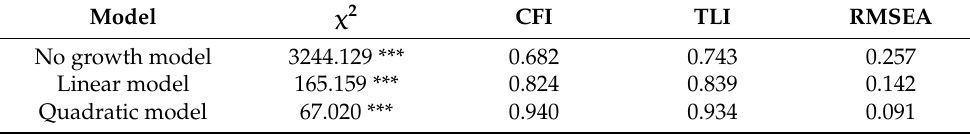
Table 2. Model fit of Latent Growth Modeling for Older Adults’ Smoking Behavior Changes. Model χ 2 CFI TLI RMSEA No growth model 3244.129 *** 0.682 0.743 0.257 Linear model 165.159 *** 0.824 0.839 0.142 Quadratic model 67.020 ***